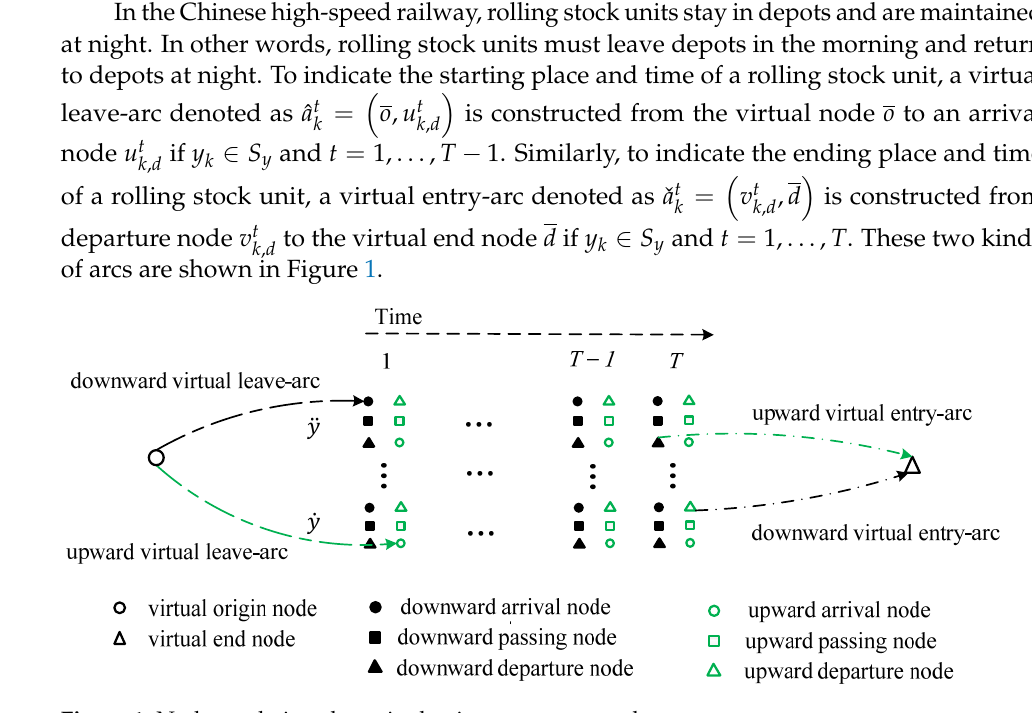
Figure 1. Nodes and virtual arcs in the time-space